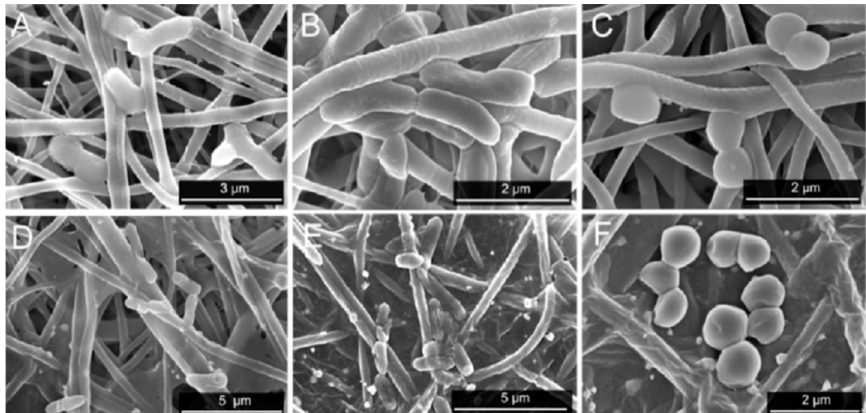
Figure 21. ( Top Row ) Number of attached live cells on PLGA-chitosan (green column) and PLGA- chitosan/GO-AgNPs (red column) mats upon exposure to E. coli , P. aeruginosa , and S. aureus bacteria. ( Bottom Row ) SEM images of E. coli ( A , D ), P. aeruginosa ( B , E ), and S. aureus ( C , F ) attached on the PLGA-CS ( A – C ) and PLGA-CS/GO-AgNPs ( D – F ) mats. * denotes statistically significant difference between PLGA-CS/GO-AgNPs and PLGA-CS (control); p < 0.05. Reproduced with permission from [173], Copyright American Chemical Society, 2015.